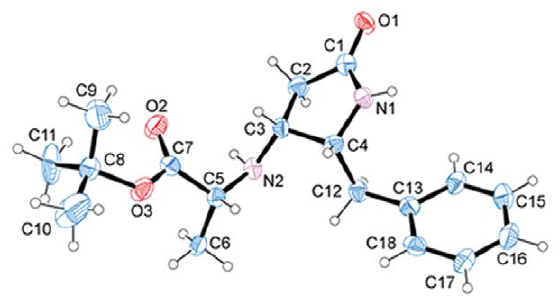
Figure 5. X-Ray molecular structure of 2-pyrrolidinone deriv- ative 4R*,5R*–7a. Atom labeling for molecule 1 or 2 can be obtained by adding 100 or 200 respectively to the label of the atom shown in this figure, i.e. O1 is labelled O101 in molecule 1 and O201 in molecule 2. Thermal ellipsoids are drawn at 50% probability level of non-H atoms, and the H atoms are denoted as spheres of 0.1 A˚ radius.